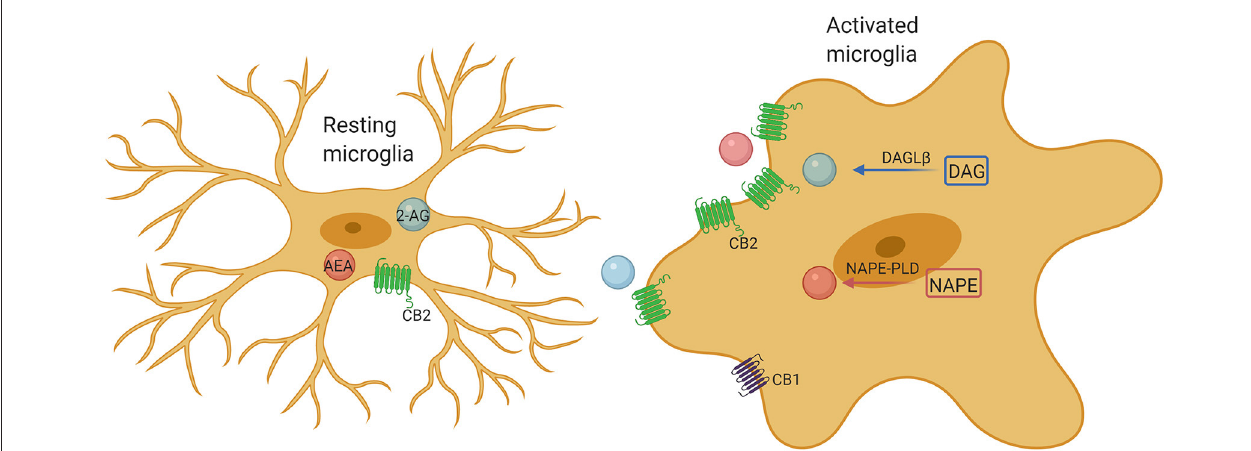
FIGURE 2 | Microglia comprise a complete endocannabinoid signaling system. Microglia produce ∼ 20-fold more endocannabinoids than neurons and other glial cells, and may be a major cellular source of endogenous cannabinoids under neuroinflammatory conditions. Upon activation, microglia markedly increase their endocannabinoids synthesis and upregulate their CB2 receptor expression, promoting protection of the microglia phenotype by enhancing their neuroprotective factor production and reducing their proinflammatory factor release.